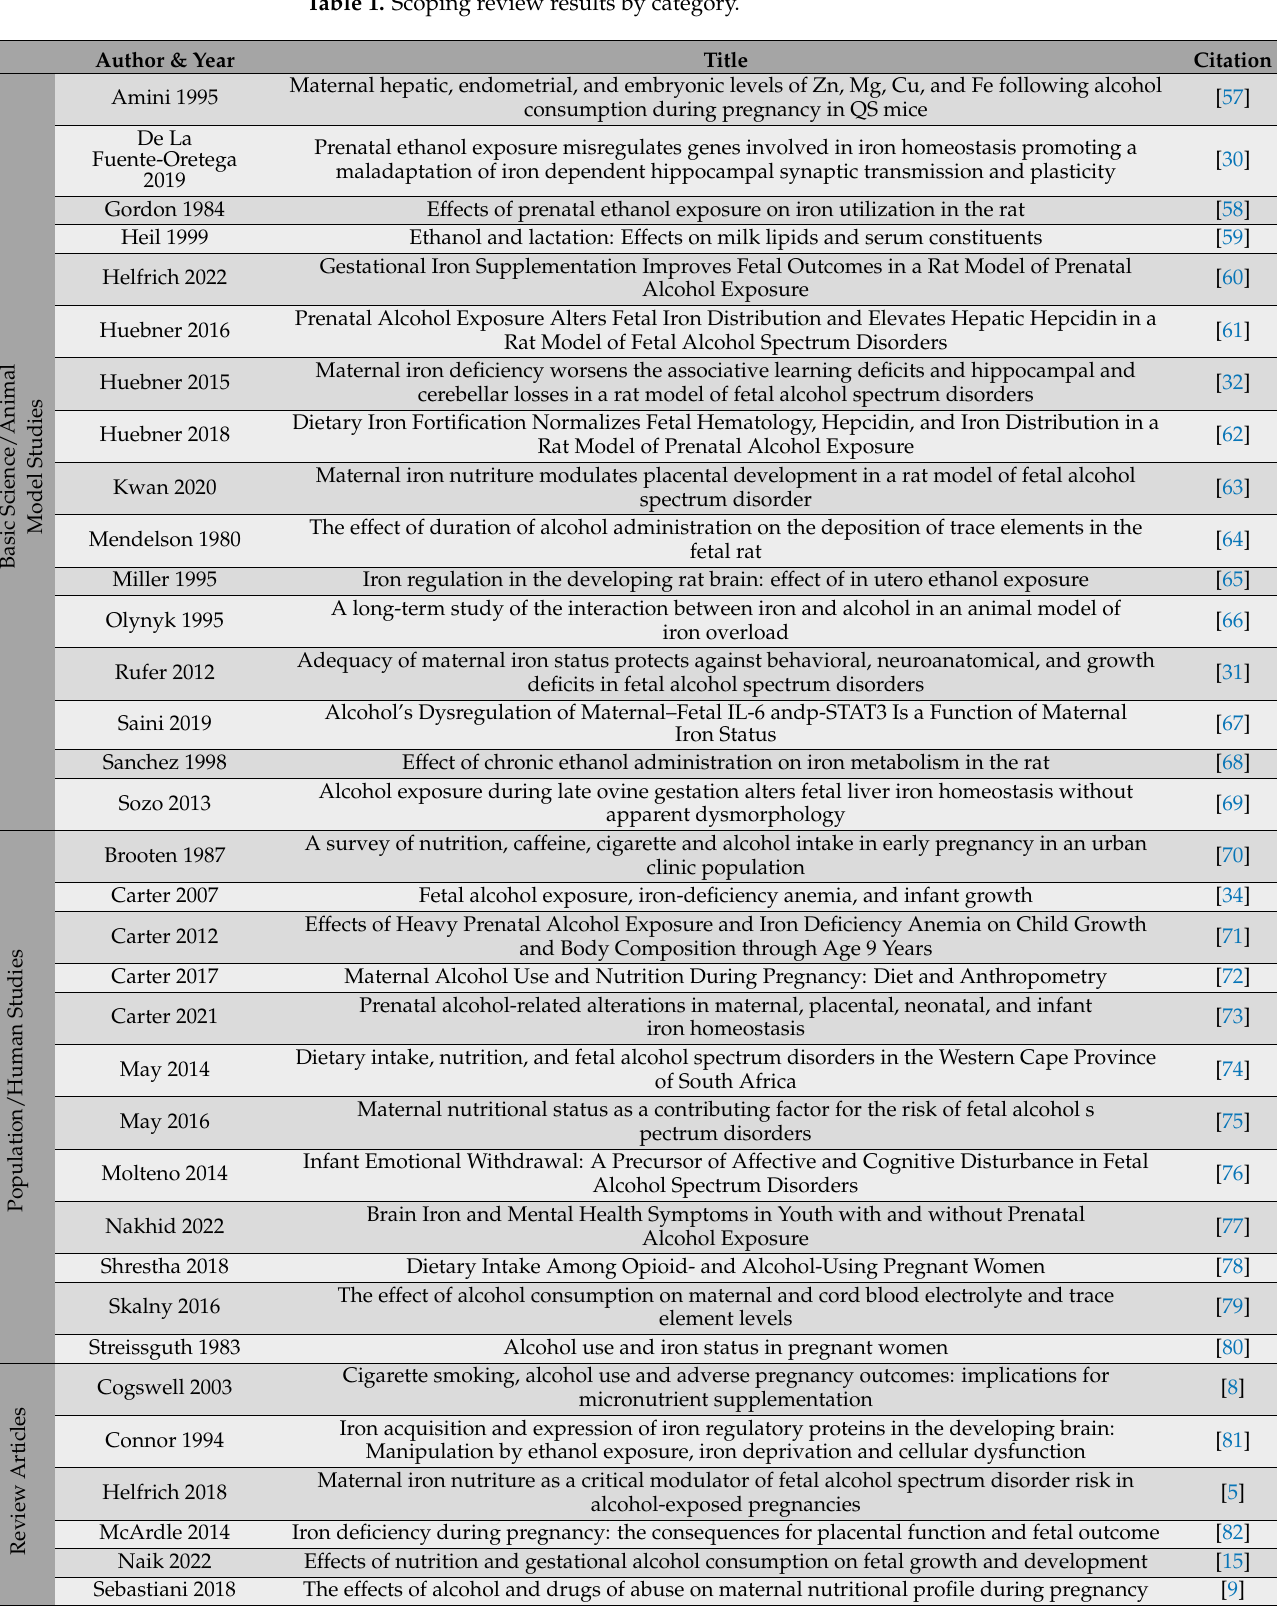
Table 1. Scoping review results by